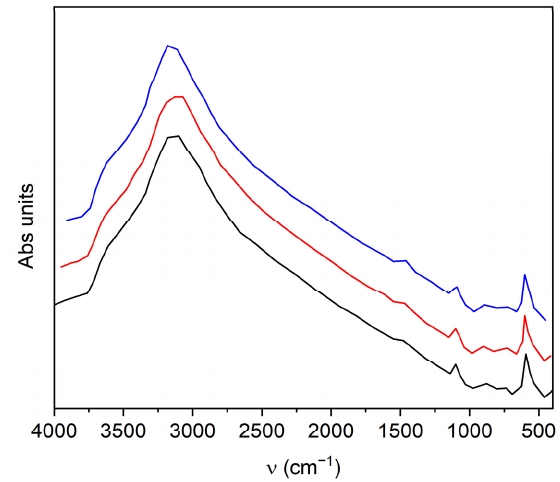
Figure 4. FTIR absorbance spectra of NPW6-1000 in air (black curve), after 1 min outgas (red curve) and after 30 min outgas (blue curve). The curves were shifted along the y -axis to better display the spectra details.